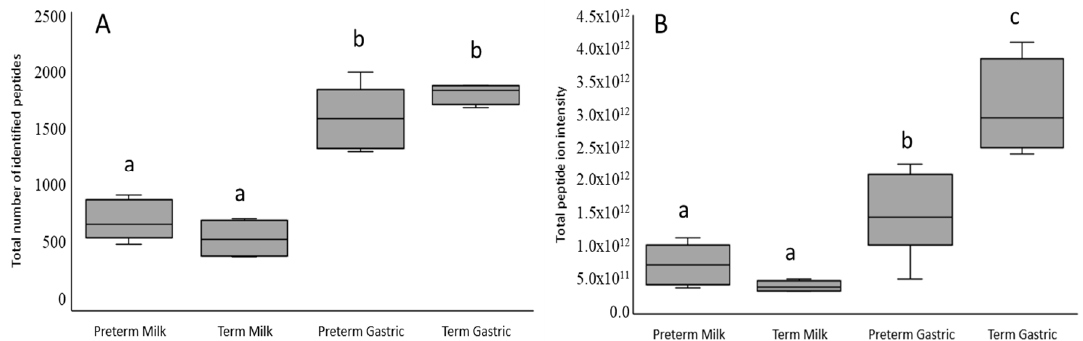
Figure 3. Differences in total number of peptides identified in mothers’ milk and infant gastric . Total count ( A ) and abundance ( B ) of peptides identified in preterm and term infant gastric samples (human milk fortified with bovine-based human milk fortifier or high-calorie infant formula, respectively) and their mothers’ milk (unfortified). Different letters indicate significantly different values ( p < 0.05). Table 2. Proteins with the highest number of identified peptides 1 . Count in Milk 2 Count in Gastric Contents 3 Protein